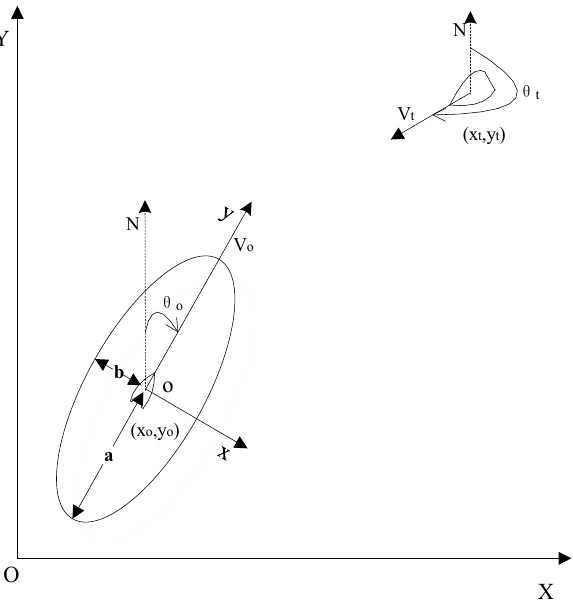
Figure 9. Relationship between own ship motion system and the target ship motion system in the earth coordinate system.